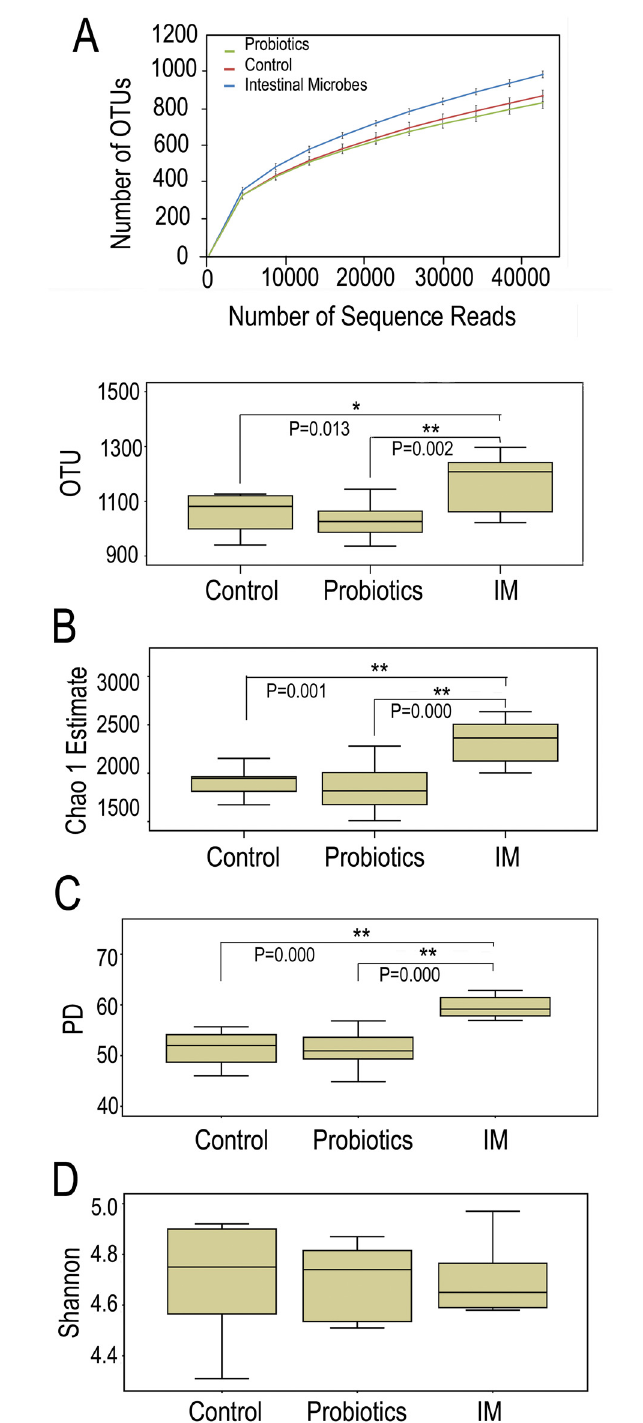
Fig 1. Comparison of bacterial richness and diversity among Control, Probiotics, and Microbes. Control mice were raised in cages with sterilized pelletized cardboard bedding, probiotics mice were raised in cages sterilized pelletized cardboard bedding added with probiotics, and intestinal microbes mice were raised in cages added with goat intestinal microbes. (A) Rarefaction curves showing unique operational taxonomic units (OTUs) (a box graph at the rarefied sequence number). (B) Chao1 estimators. (C) Phylogenetic diversity (PD). (D) Shannon index. (n = 8; * p < 0.05, ** p < 0.01, based on a two-tailed least significant difference